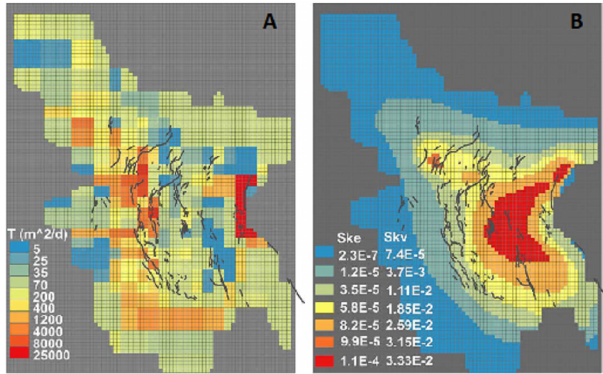
Figure 3. Calibrated (a) transmissivity and (b) storage zones.